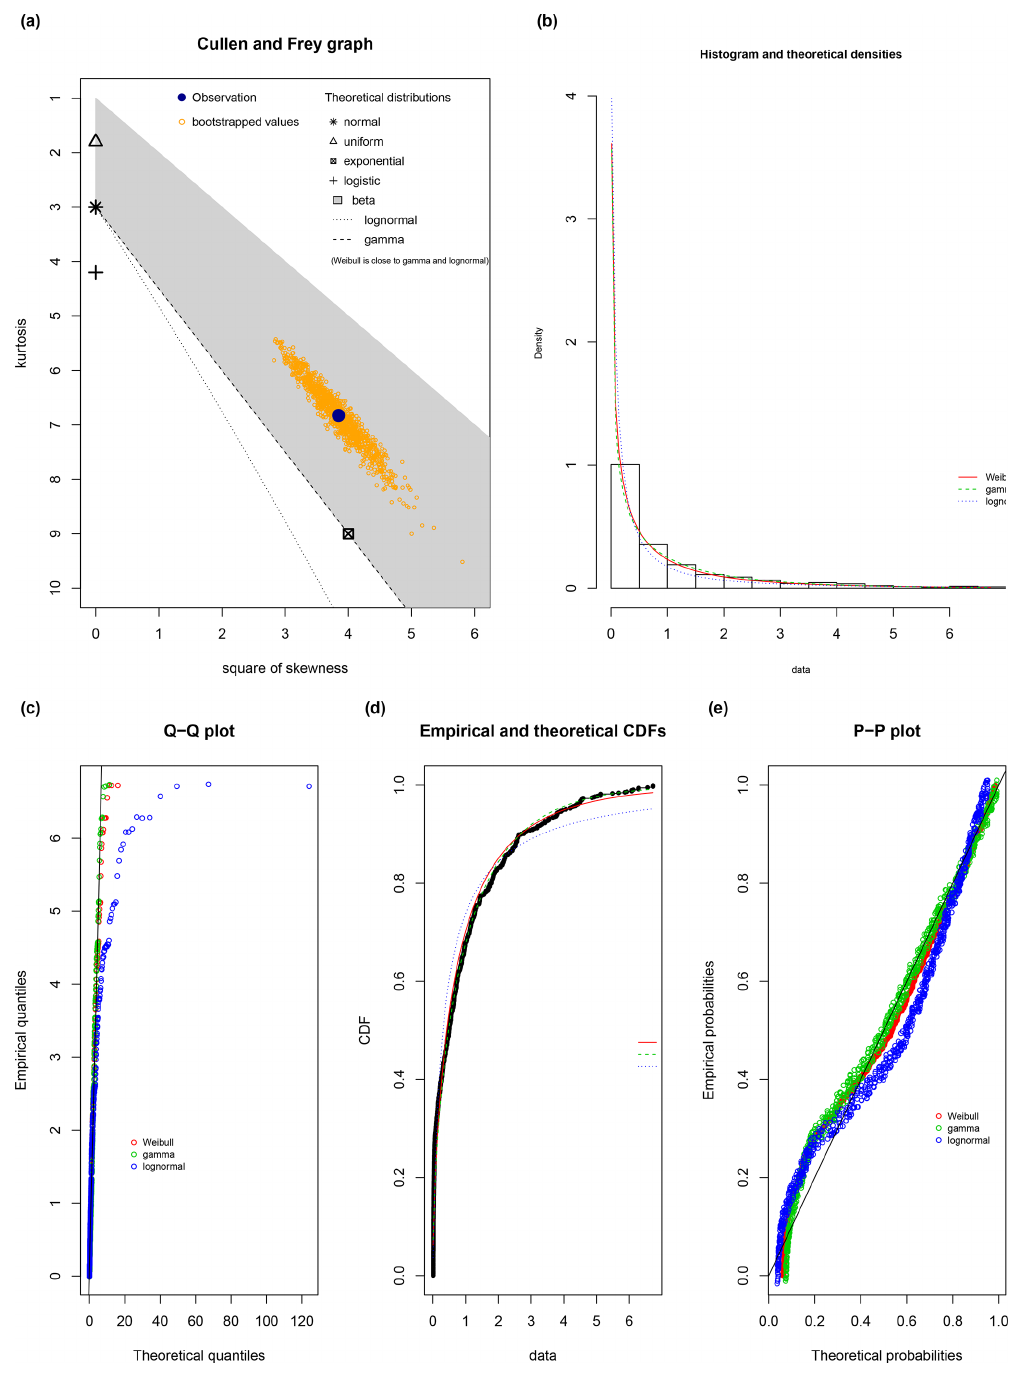
Figure F1. Choice of distribution for drag